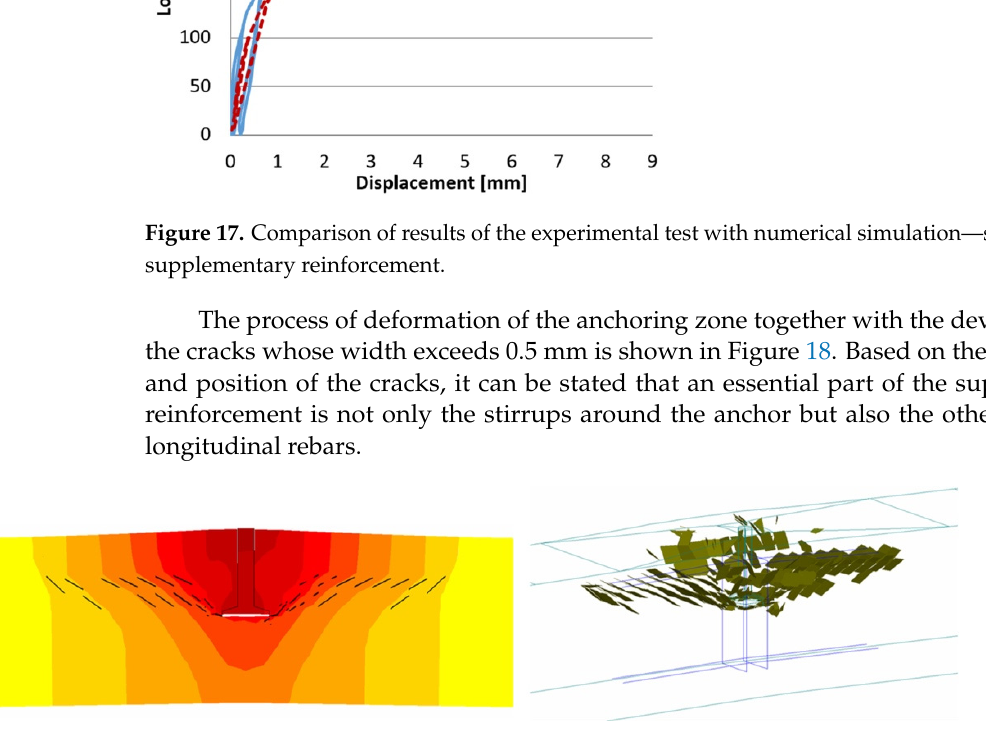
Figure 18. Deformation of the anchorage zone and the formation of cracks with a width greater than 0.5 mm—anchor with supplementary reinforcement (the picture does not show the longitudinal and shear reinforcement of the specimen).